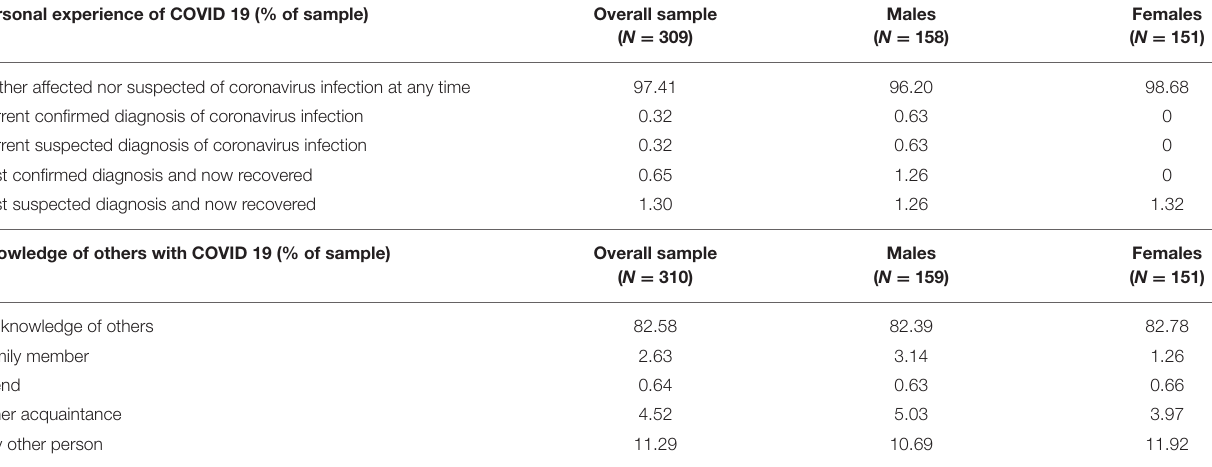
TABLE 1 | Personal experience of and knowledge of others with COVID-19 (Of note, while the first set of questions about personal experiences of COVID-19 reflects mutually exclusive response options (therefore adding up to 100%), the set of questions around knowledge of others are not all mutually exclusive. For instance, a participant reporting a family member as well as an acquaintance infected with the virus would be included twice, once when calculating the percentage of participants reporting an infected family member and once when calculating the percentage of participants having an infected acquaintance. Therefore, participants having knowledge of others with COVID-19 do not add up to